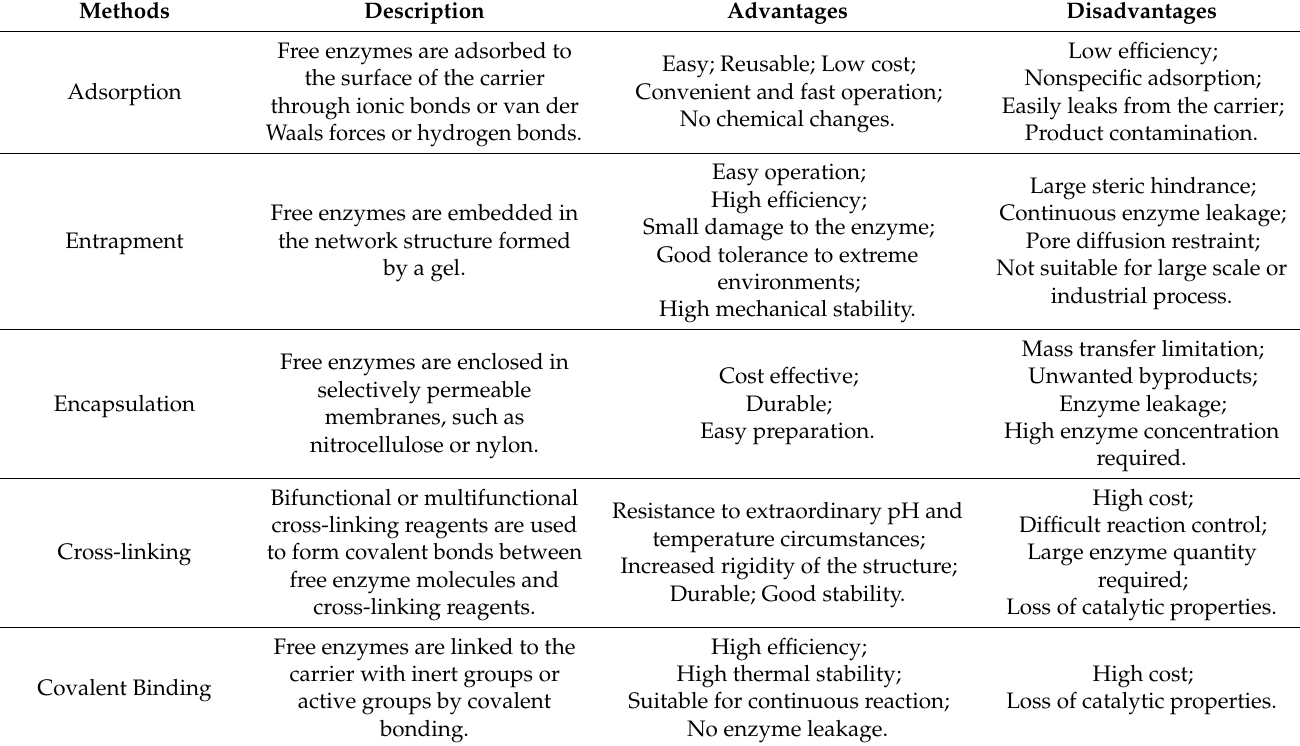
Figure 3. The most commonly used techniques for immobilization of enzymes [53]. Table 2. The various immobilization methods and their advantages and disadvantages [53,55–63].